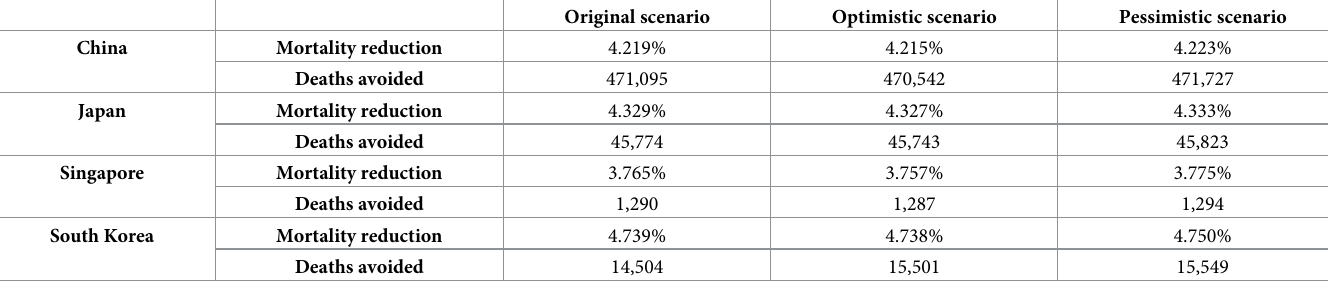
Table 5. Sensitivity analysis: Mortality reduction through 2040 with varying smoking intensity and cessation